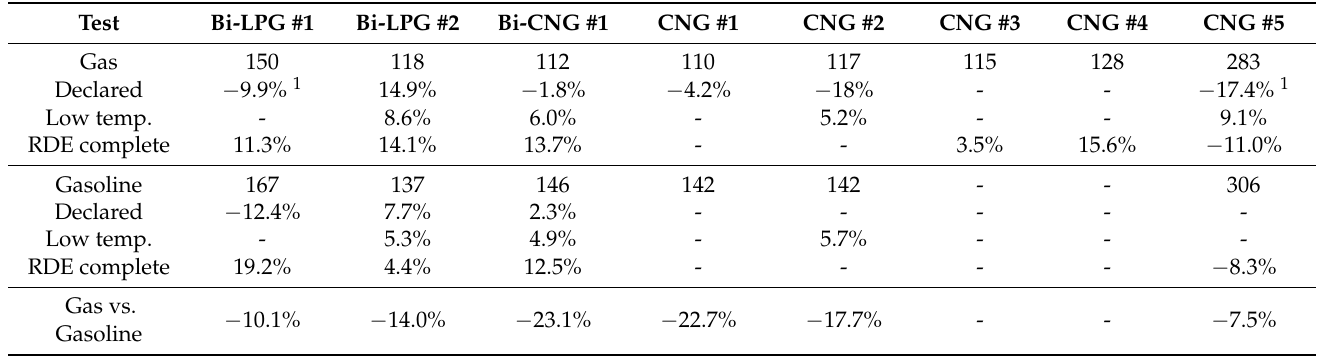
Table 1. Cold start at 23 ◦ C WLTC CO 2 measured emissions (in g/km) and differences of declared, low temperature WLTC, and RDE complete tests from the measured WLTC at 23 ◦